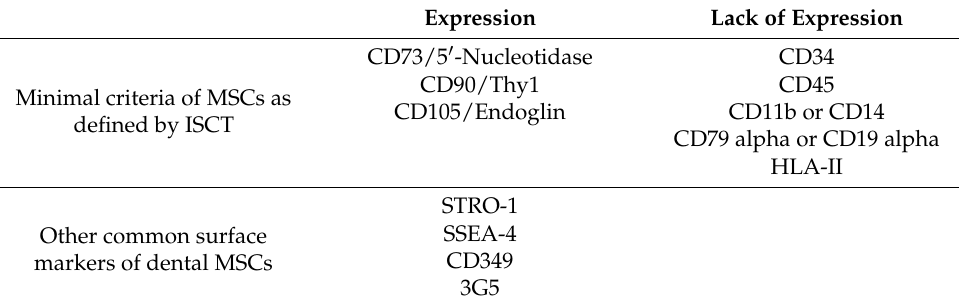
Table 1. Surface markers of MSCs of dental origin Minimal criteria of MSCs as defined by ISCT Other common surface markers of dental MSCs